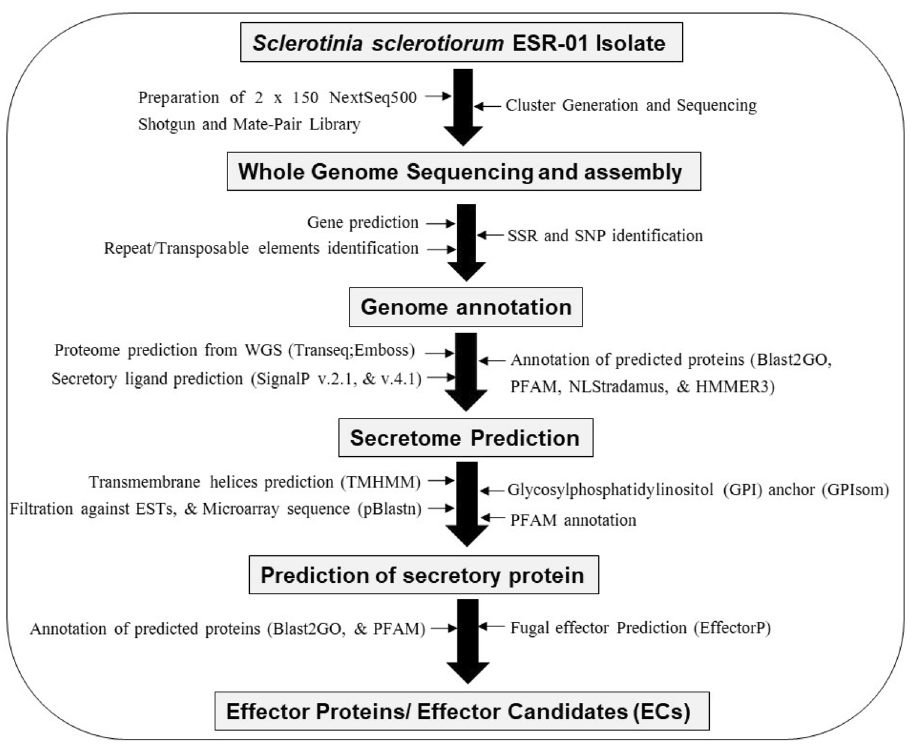
Figure 9. A schematic outline of the S. sclerotiorum ‘ESR-01’ whole genome sequencing and bioinformatic